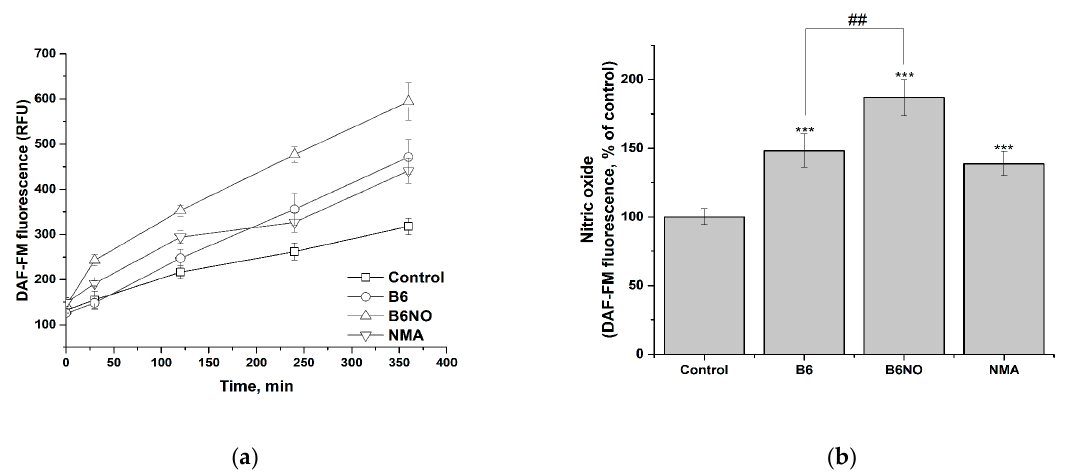
Figure 7. Influence of B6NO, vitamin B6 and NMA on the intracellular NO formation in Vero cells and measured using the DAF-FM assay. Time dependence of intracellular nitrogen monoxide concentration ( a ) and relative concentration of intracellular nitrogen monoxide after 6 h of exposure to compounds ( b ). Significant differences are shown as *** p < 0.001 vs. control; as ## p < 0.01 B6NO vs. vitamin B6.